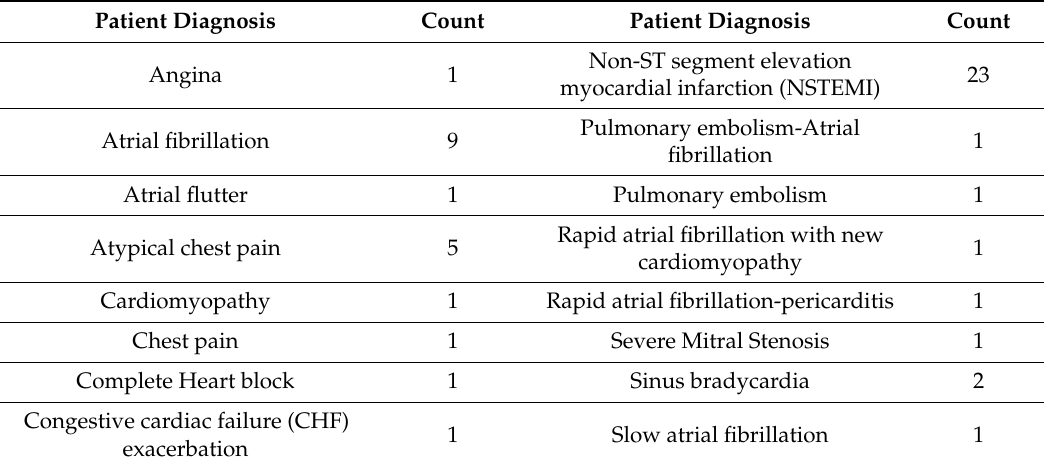
Table 2. Patient diagnosis